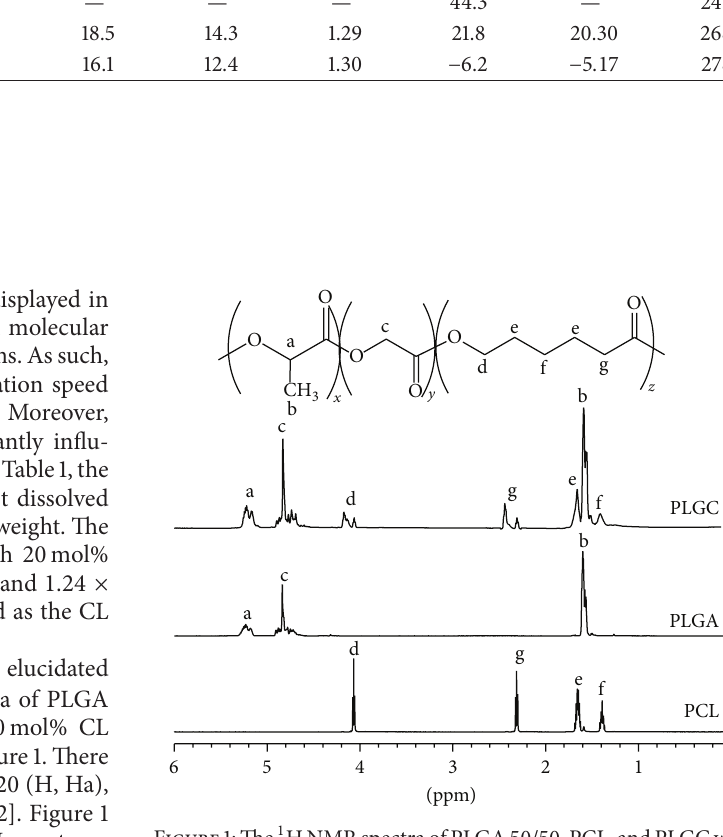
Figure1:The 1 HNMRspectraofPLGA50/50,PCL,andPLGCwith 20 mol% CL